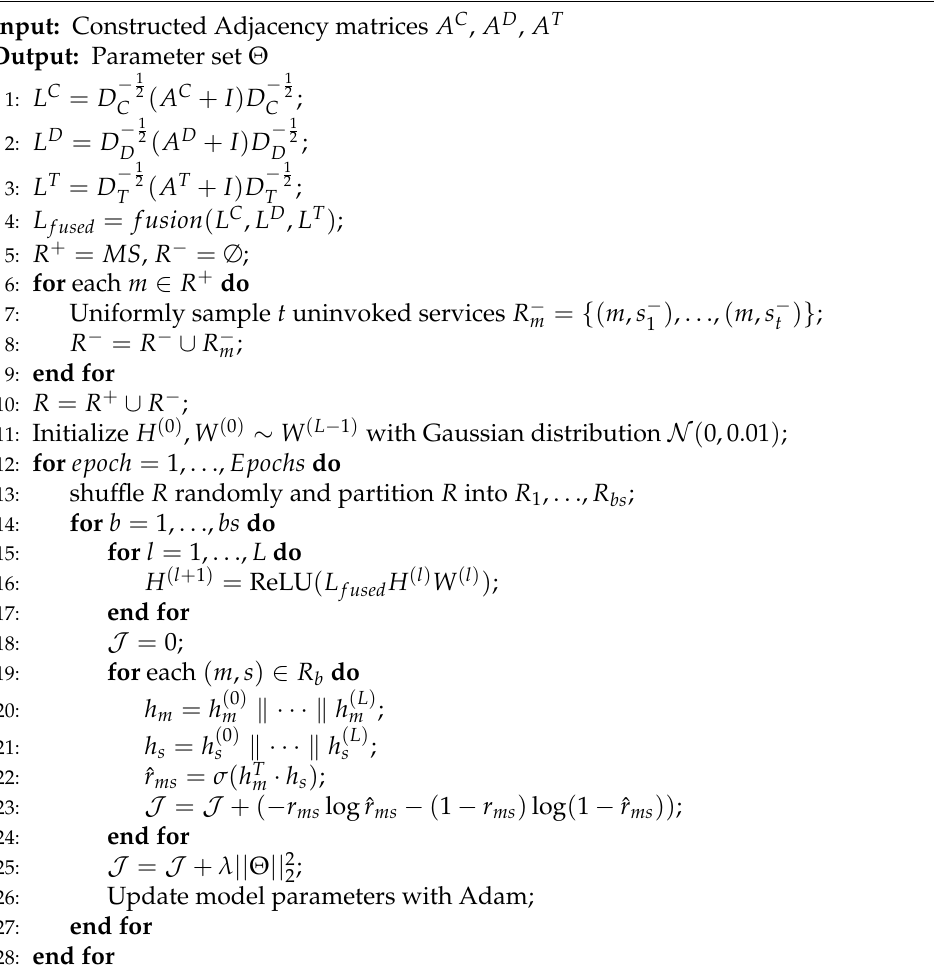
Algorithm 1 Training algorithm of